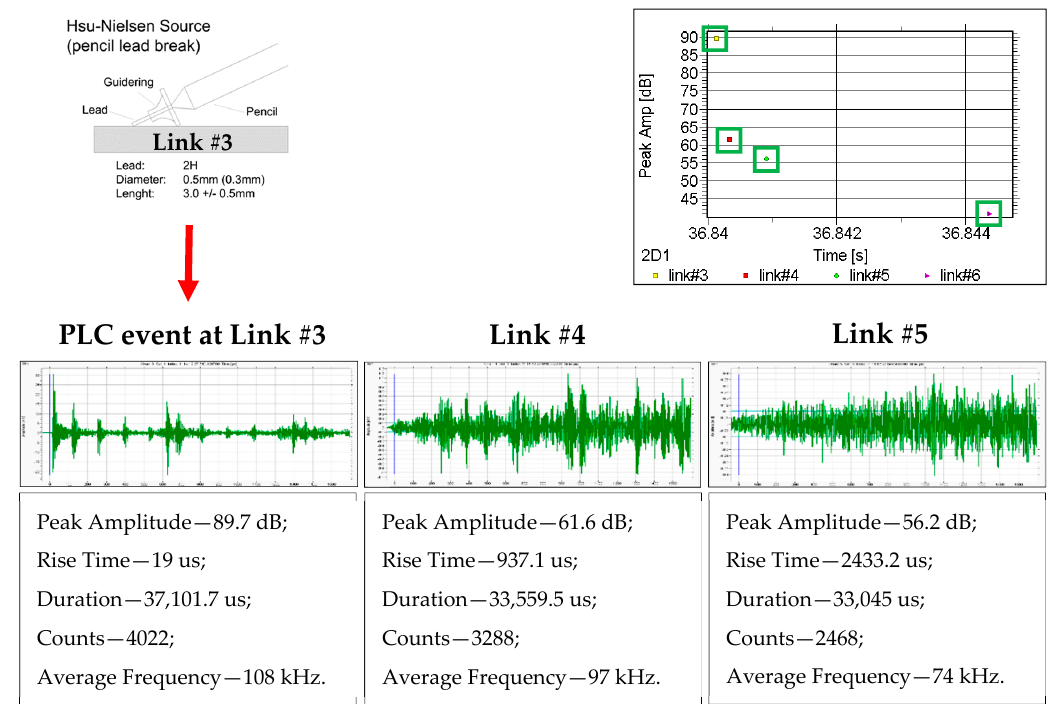
Figure 5. A pencil lead calibration (PLC) event generated in Link 3.